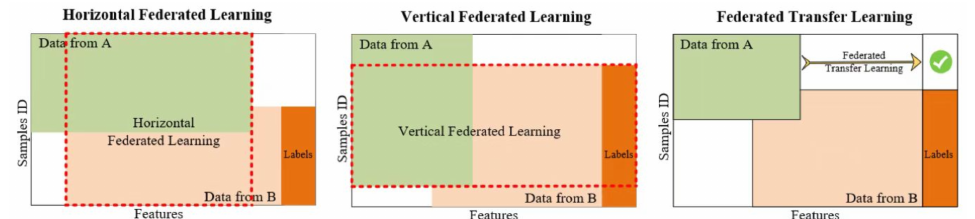
Figure 1. Illustration of three types of federated learning: horizontal federated learning, vertical federated learning and federated transfer